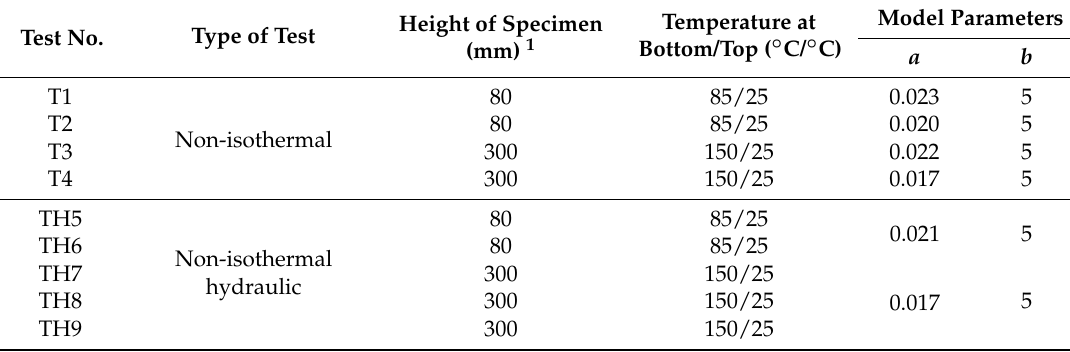
Table 2. Model fitting parameters for temperature